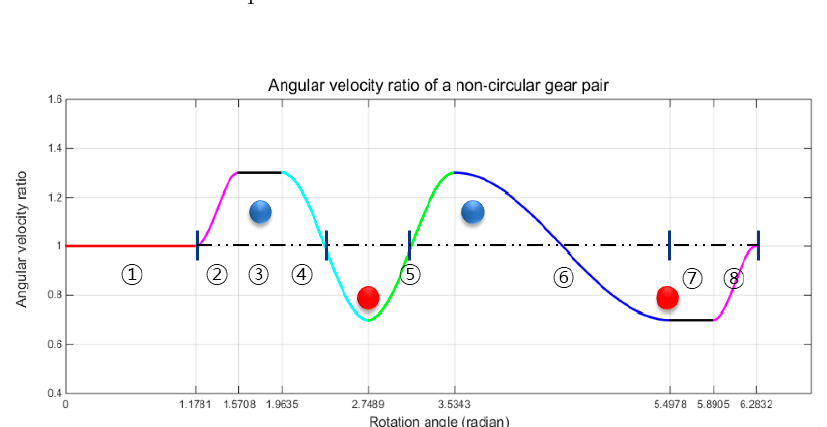
Figure 4. Sectional angular velocity ratio of driving gear to driven gear.